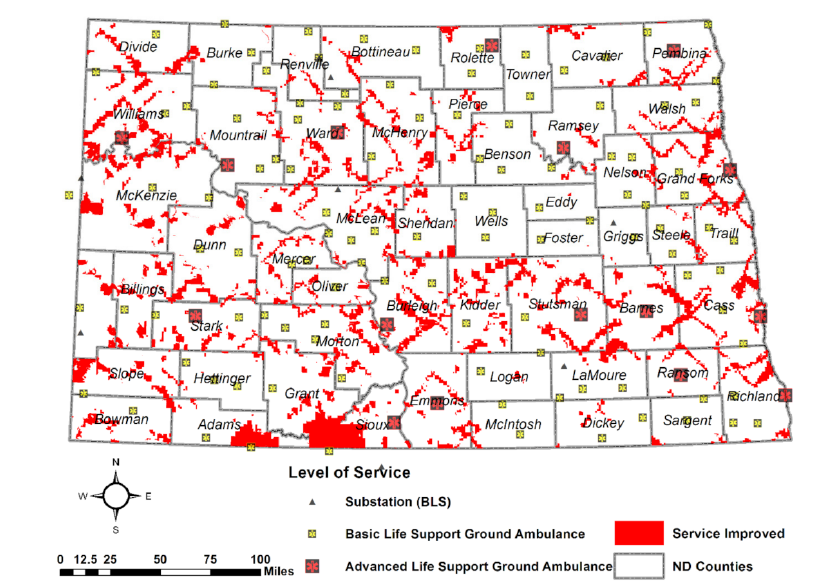
Figure 4. Service coverage improved by increasing travel speed and lowering chute time (Scenario 4 compared to Scenario